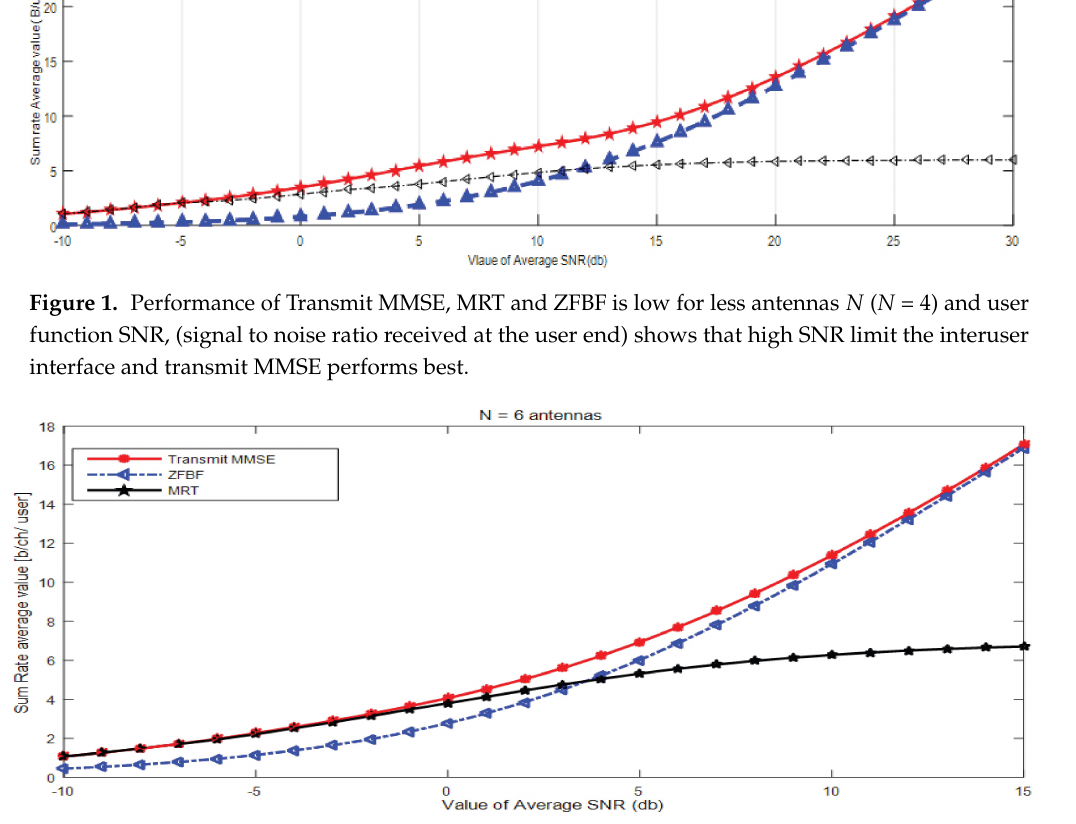
Figure 2. Performance of Transmit MMSE, MRT and ZFBF increase with antennas N ( N = 6), with ZFBF and MRT compensate against average SNR and user function SNR (signal to noise ratio received at the user end) shows that high SNR limit the interuser interface and transmit MMSE performs